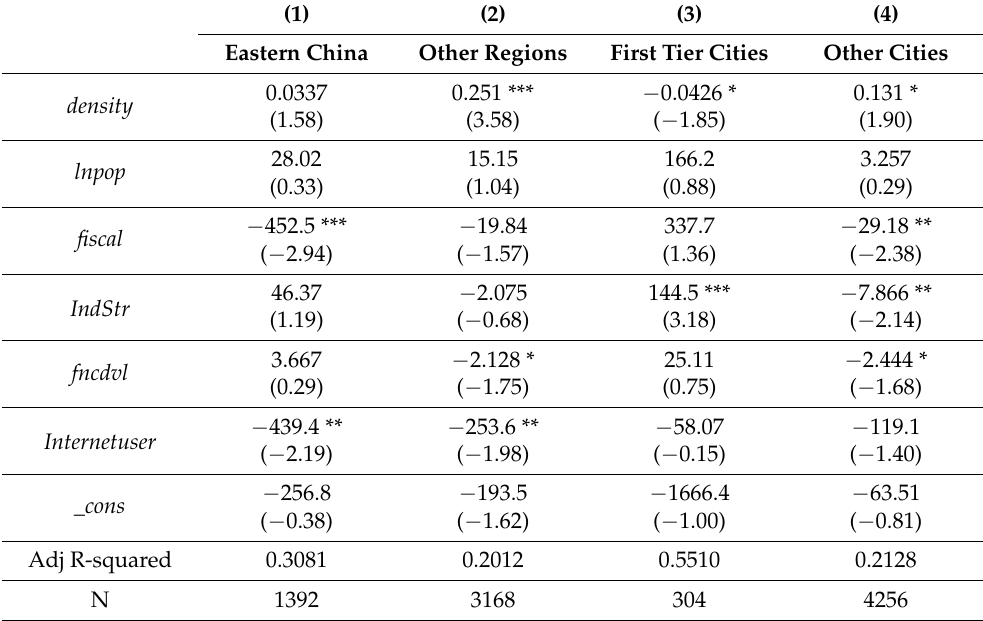
Table 7. Heterogeneous effects: impact of density on credit